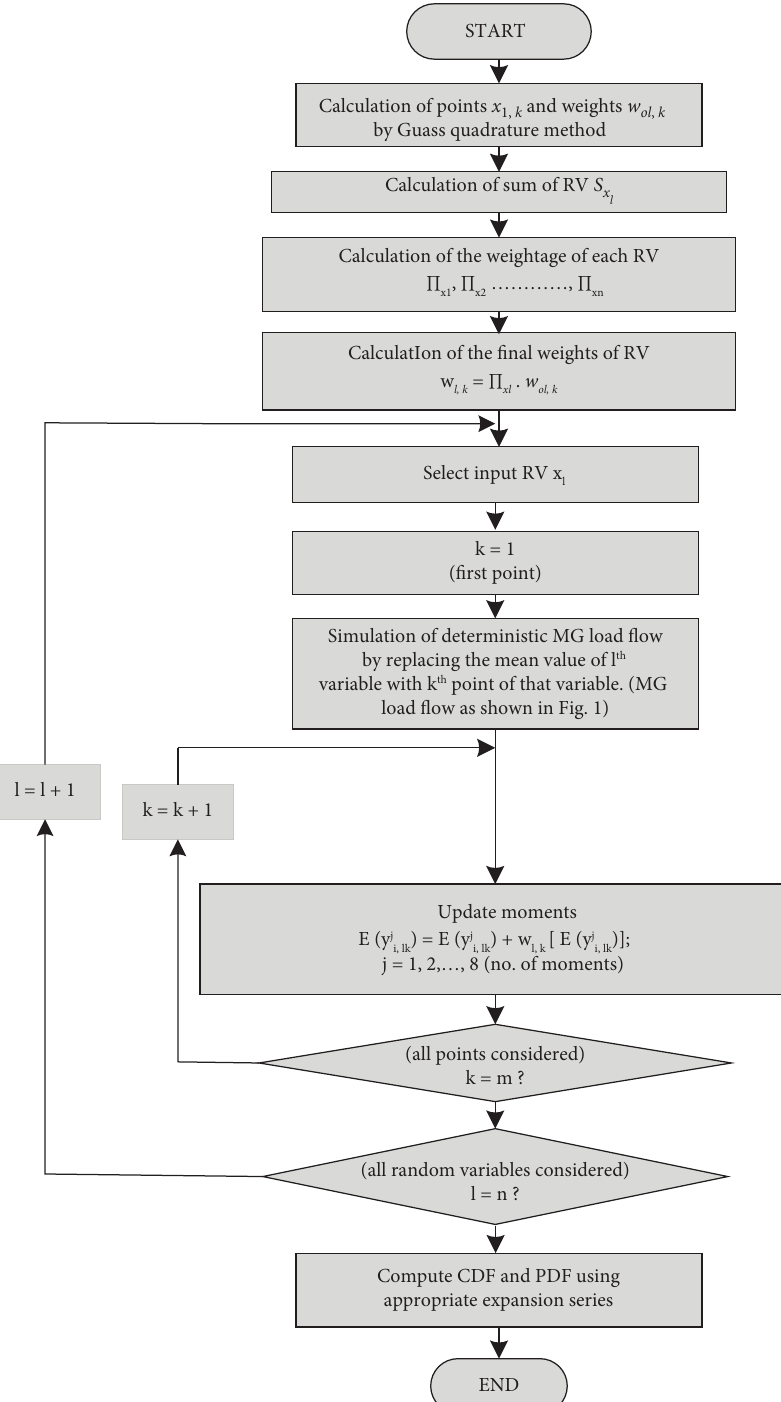
Figure 2: Gauss quadrature-based load fow of an islanded